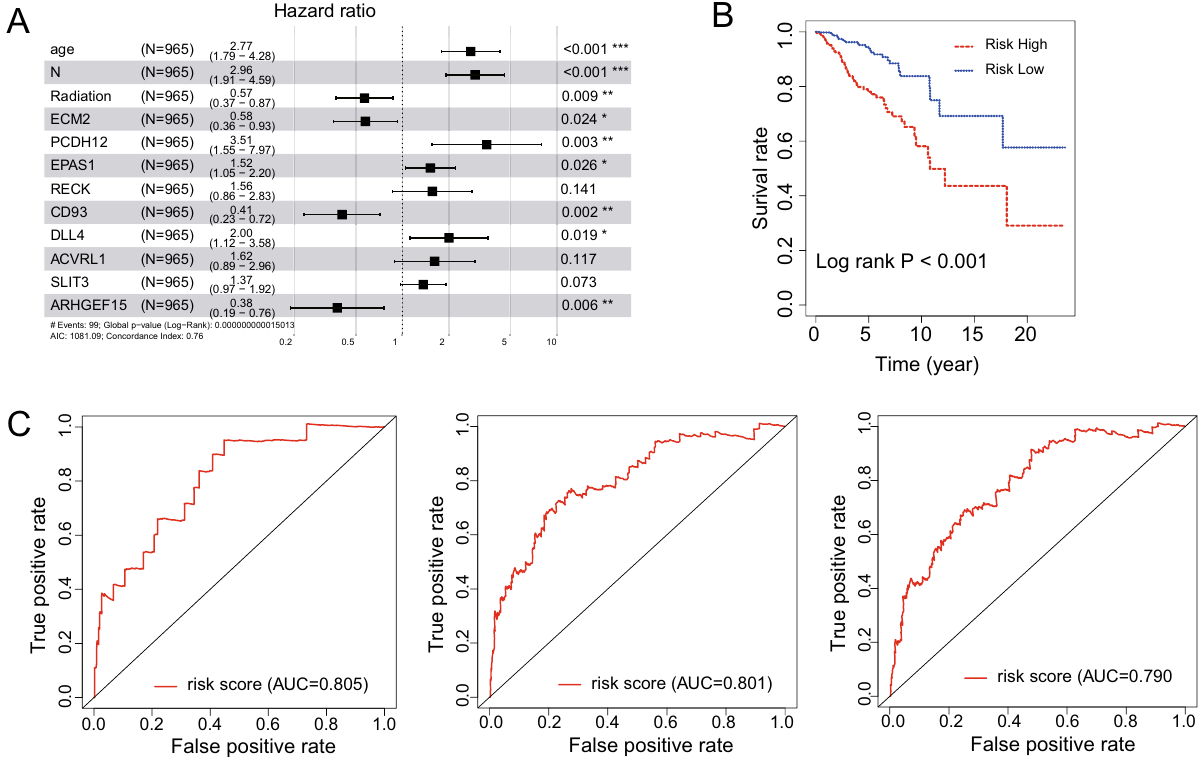
Figure 6. Efficiency evaluation of multivariate regression analysis and risk scoring. ( A ) The results of the multi-factor analysis displayed by the forest map. ( B ) Kaplan–Meier survival curves of high-risk and low-risk groups. ( C ) Time-dependent ROC applied to evaluate the accuracy of the model in predicting 1-, 3-, and 5-year